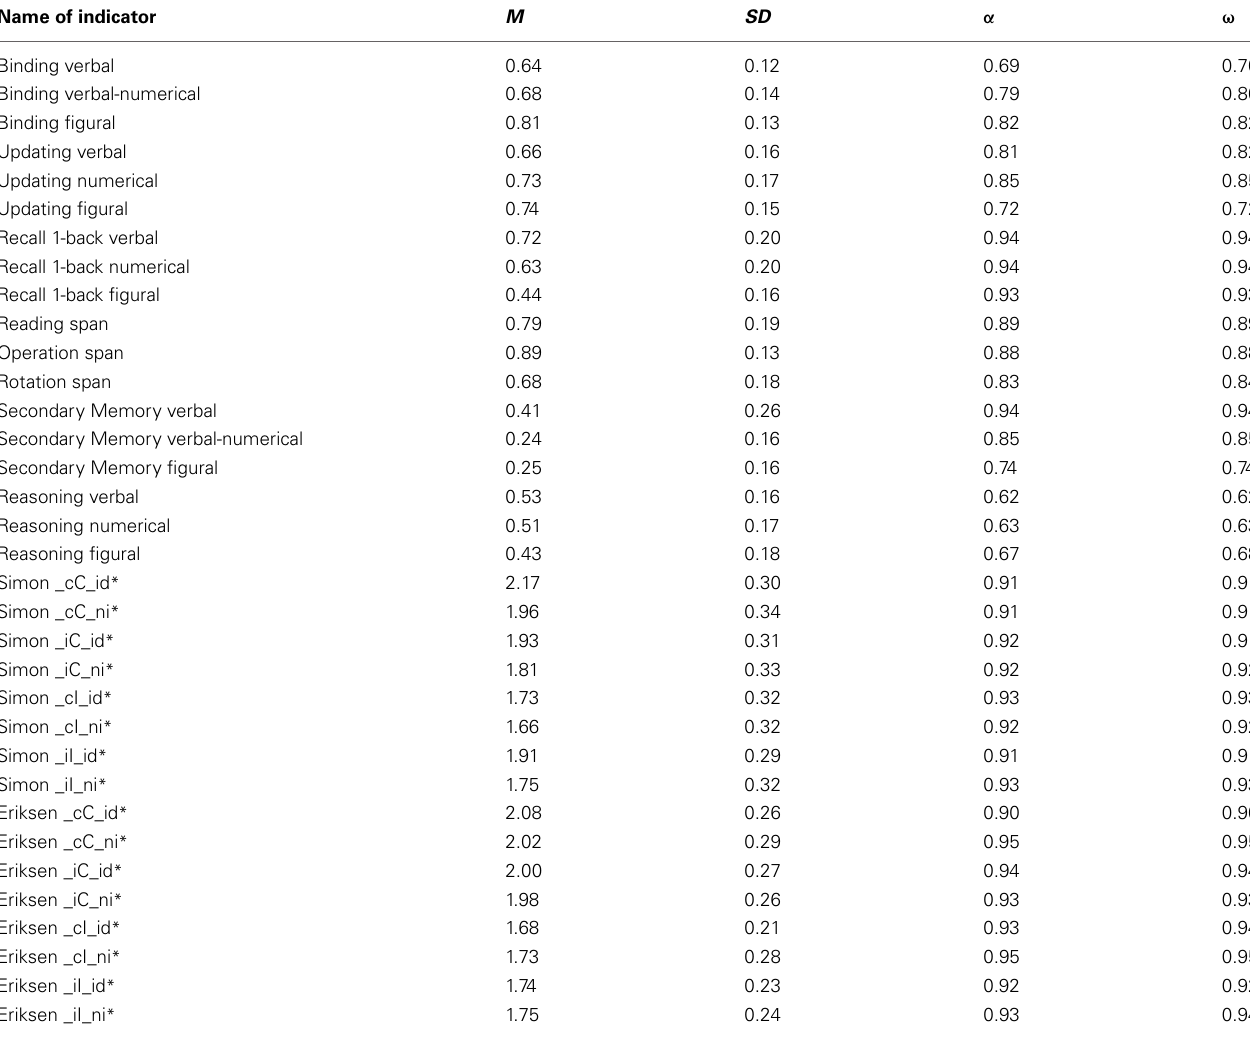
Table A2 | Descriptive statistics—all performance